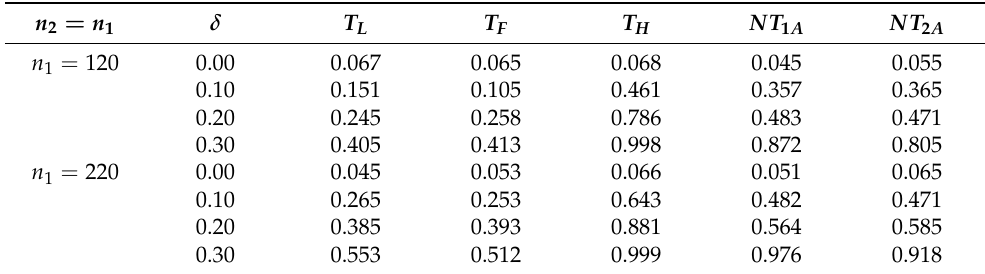
Table 1. Size and power of five methods in Setting 1 (mean difference lies in early part µ 2 [ 1 : 6 ] = µ 1 [ 1 : 6 ] + δ ).